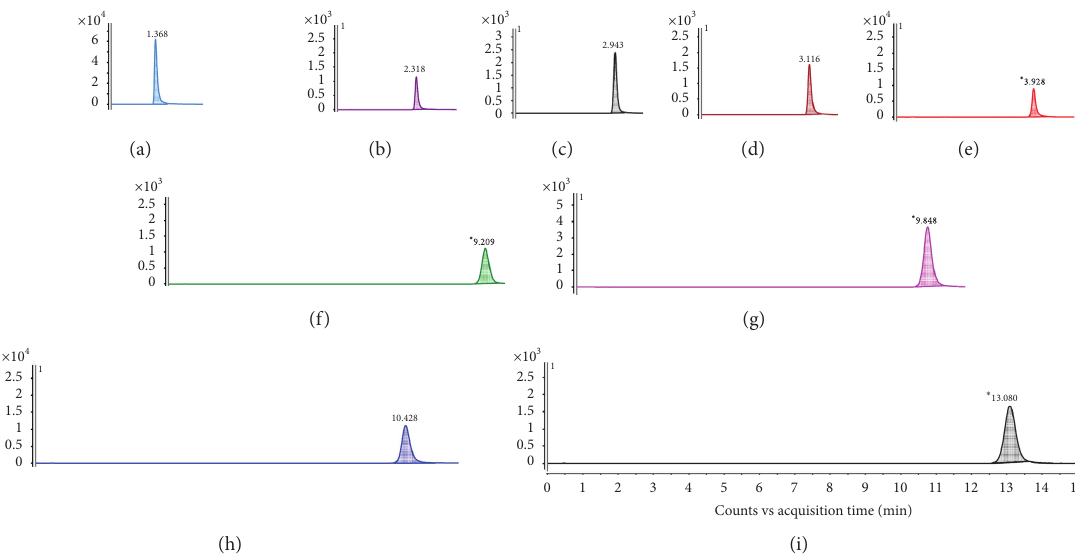
Figure 2: Typical MRM chromatograms of 9 aristolochic acid analogues reference standards. (a) AL AIIIa, (b) AA IIIa, (c) 7-OH AAI, (d) AA IVa, (e) AL FI, (f) AA II, (g) AL BII, (h) AL I, and (i) AA I.